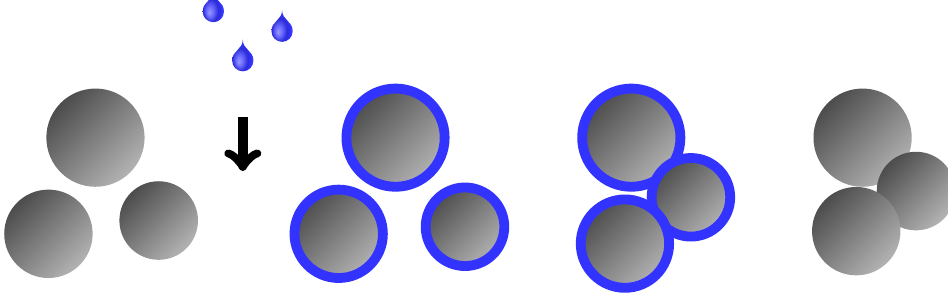
Figure 2. Agglomeration subprocess resulting in a blueberry-like particle